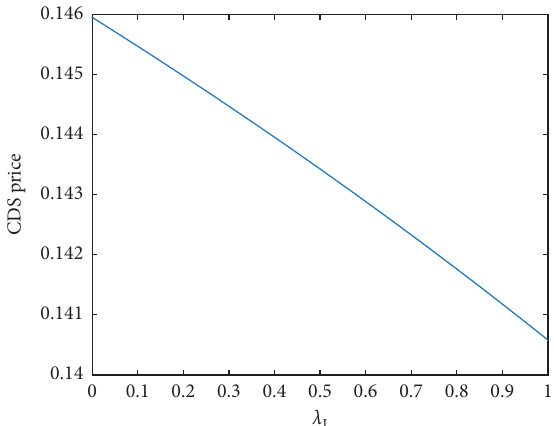
Figure 8: The CDS prices under different λ